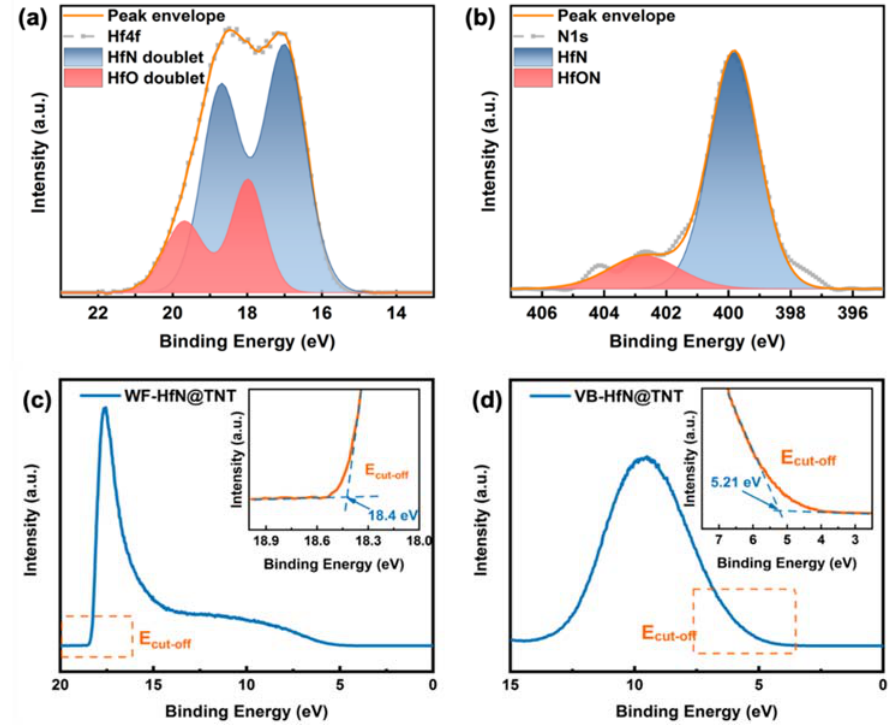
Figure 3. ( a , b ) Deconvoluted XPS spectra for Hf 4f and N 1s, respectively; ( c , d ) work function and valence band maximum with respect to vacuum level from ultraviolet photoelectron spectroscopy.